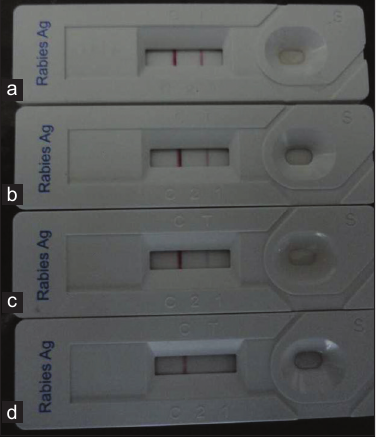
Figure-1: Detection limit immunochromatographic diagnostic test, (a) 1:100 dilution, strong positive bands were observed both in the test line and the control line, (b) 1:1000 dilution, weak positive band was observed in the test line and strong band in control line, (c) 1:10,000 dilution, very weak positive band was observed in test line and strong band in control line, (d) only control band appeared, negative Table-1: Test results of FAT and immunochromatographic test kit. Test Brain FAT Brain FAT Total positive negative